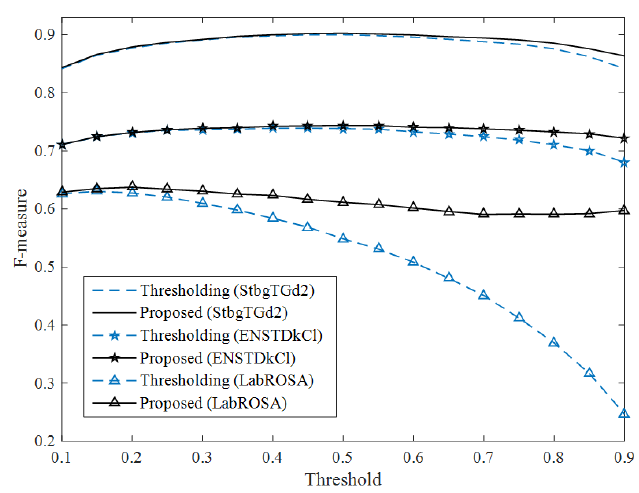
Figure 3. F-measure on the three test sets as a function of the threshold.